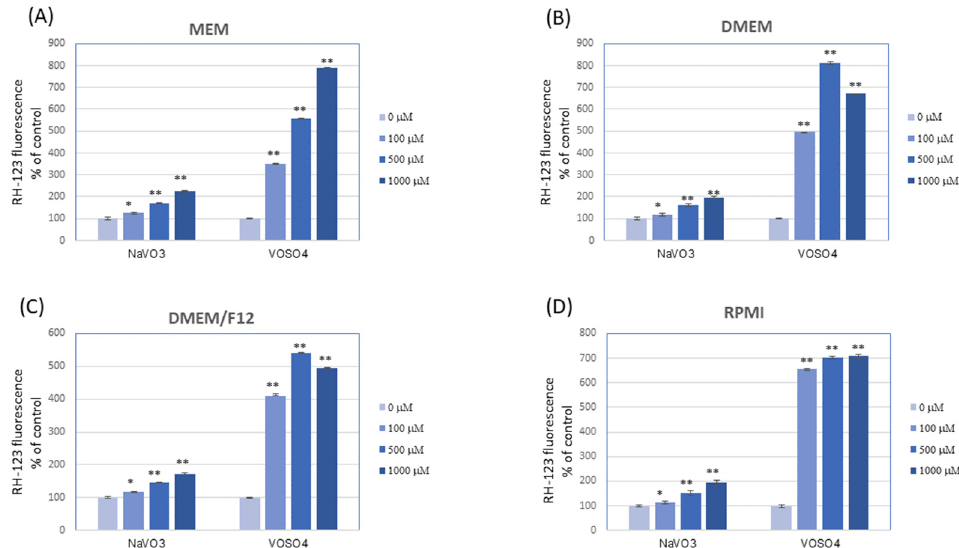
Figure 3. Oxidation of dihydrorhodamine 123 (DHR 123) to fluorescent rhodamine 123 (RH-123) in culture media after the addition of VOSO 4 or NaVO 3 . The cell-free culture media were exposed to VOSO 4 or NaVO 3 (final concentrations of 100, 500, and 1000 µM) followed by the addition of the DHR 123 probe (final concentration of 25 µM) and incubated for 15 min at 37 °C; ( A ) MEM; ( B ) DMEM; ( C ) DMEM/F12; ( D ) RPMI. The data are presented as means with error bars representing standard deviation. The data are representative of at least two independent experiments. Statistical differences between the control and the V-exposed media: * p < 0.05, ** p < 0.001 (one-way ANOVA followed by Dunnett’s T3 test).